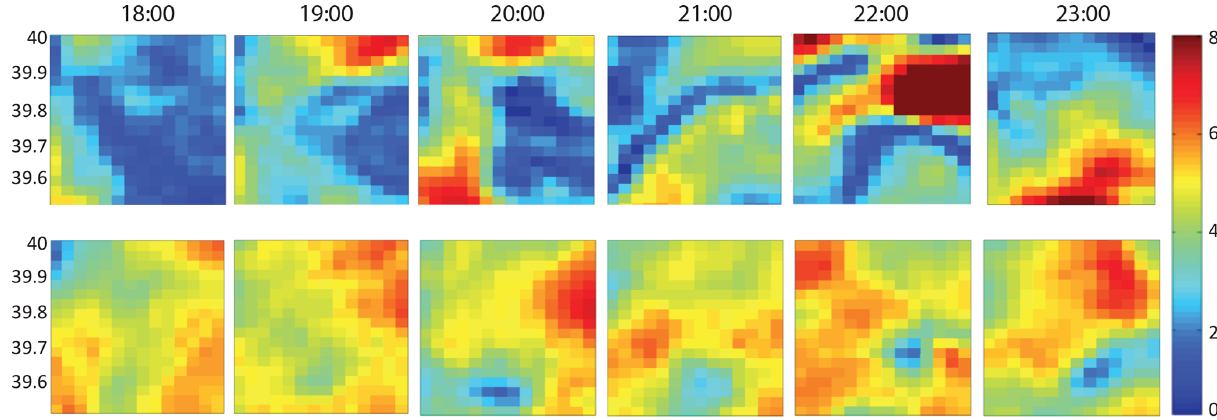
Figure 5. Winds for successive hours from 18:00 to 23:00UTC on the second (4 July – top row) and third (5 July – bottom row) days of the